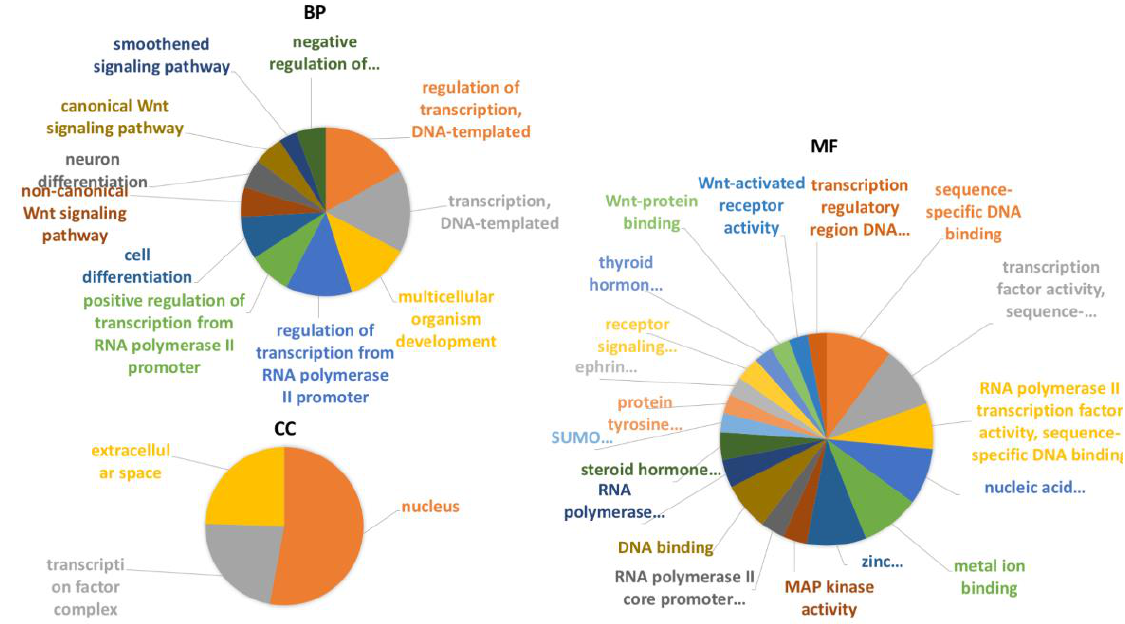
Figure 5. Gene Ontology enrichment analysis of C. robusta transcripts which were predicted to interact with specific miRNAs and pseudogenes obtained by NGS sequences. All the three different Gene Ontology subcategories were investigated: (i) biological pathways (BP); (ii) molecular functions (MF); (iii) and cellular components (CC). Table 5. mRNA-miRNA-pseudogene interaction network of Tgf-β , Wnt , FoxO , and Hh pathways. miRNA and pseudogenes interacting couples are showed in the same row.